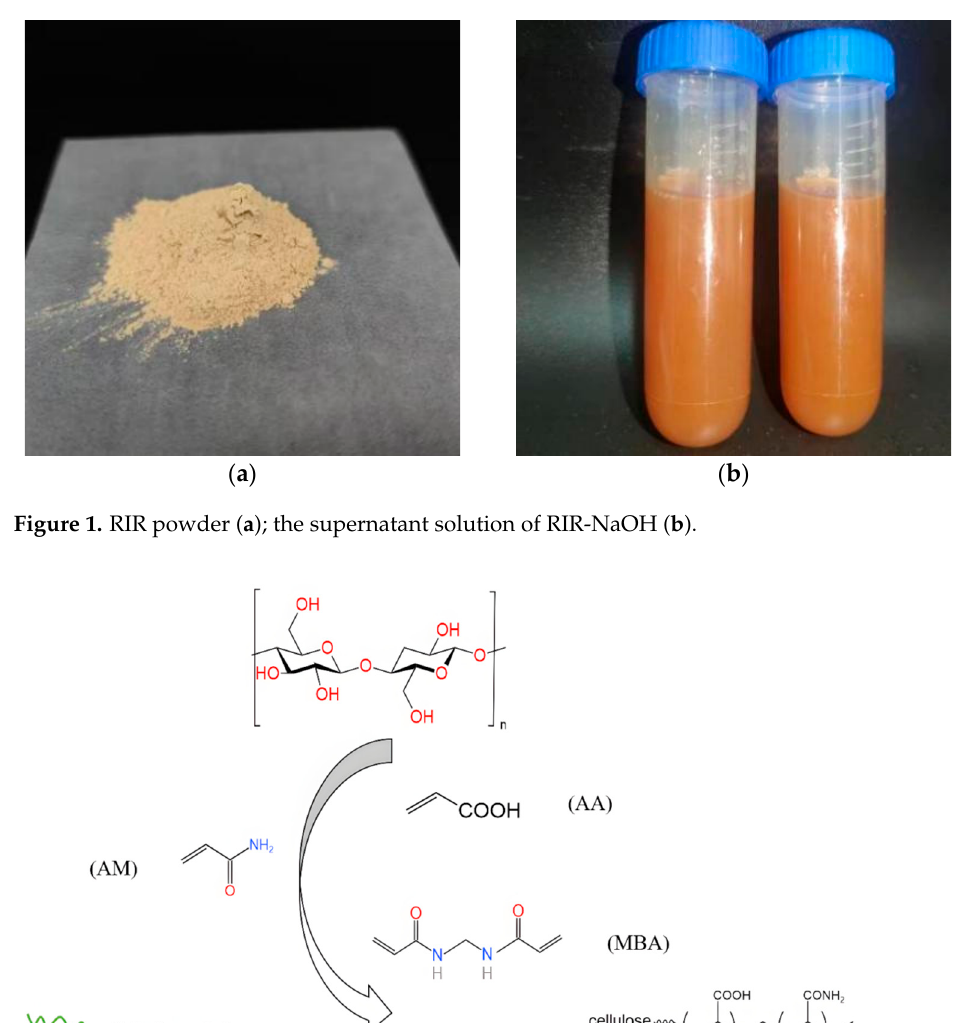
Figure 2. The synthesis scheme of RIR/AA-co-AM hydrogel.